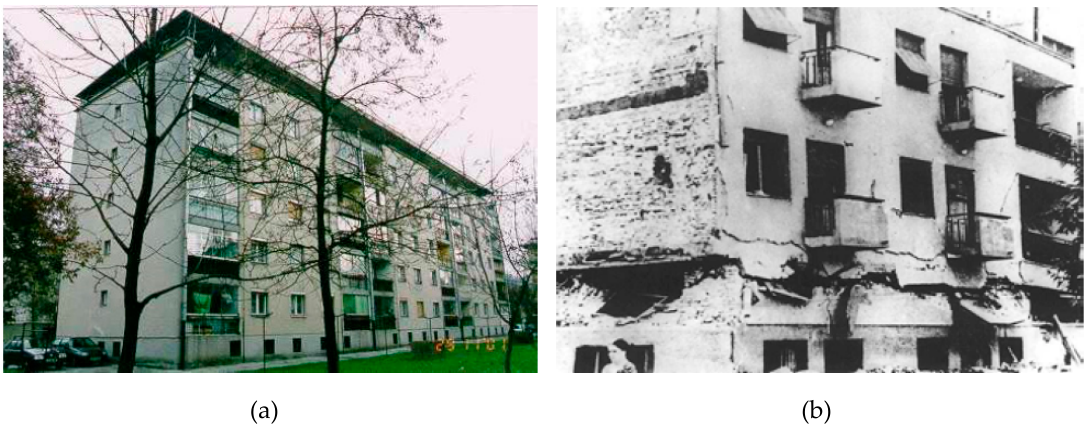
Figure 2. ( a ) Typical building in Slovenia; ( b ) devastation of a typical building after the 1963 Skopje earthquake [4].